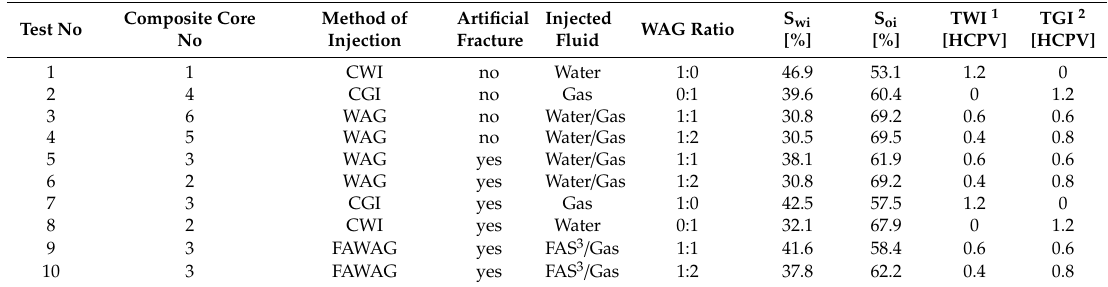
Table 6. Coreflooding experiments properties.